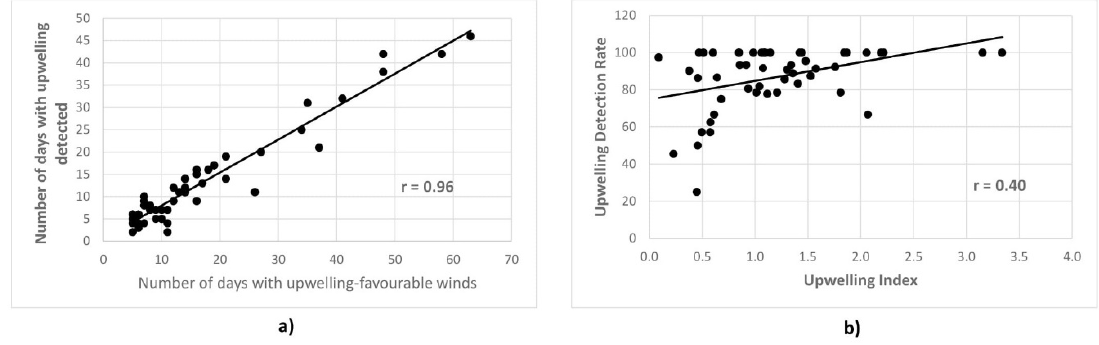
Figure 12. ( a ) Correlation between the number of days with upwelling-favorable winds and the number of days with upwelling detected from the H-8 SST data (n = 50); ( b ) correlation between the wind-driven upwelling index and the upwelling detection rate from the H-8 SST data. Each point represents one significant upwelling-favorable wind event (n = 50).